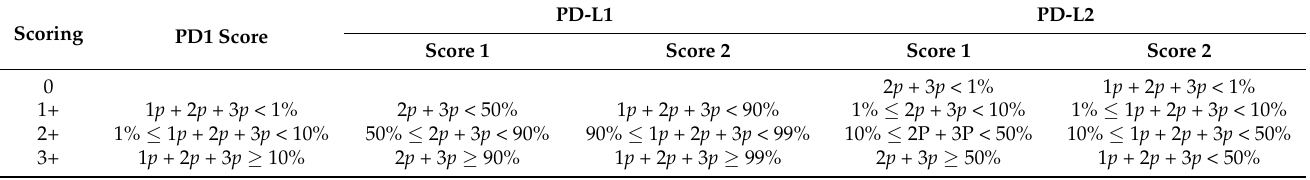
Table 1. Scoring system for immune checkpoint markers using an automated image